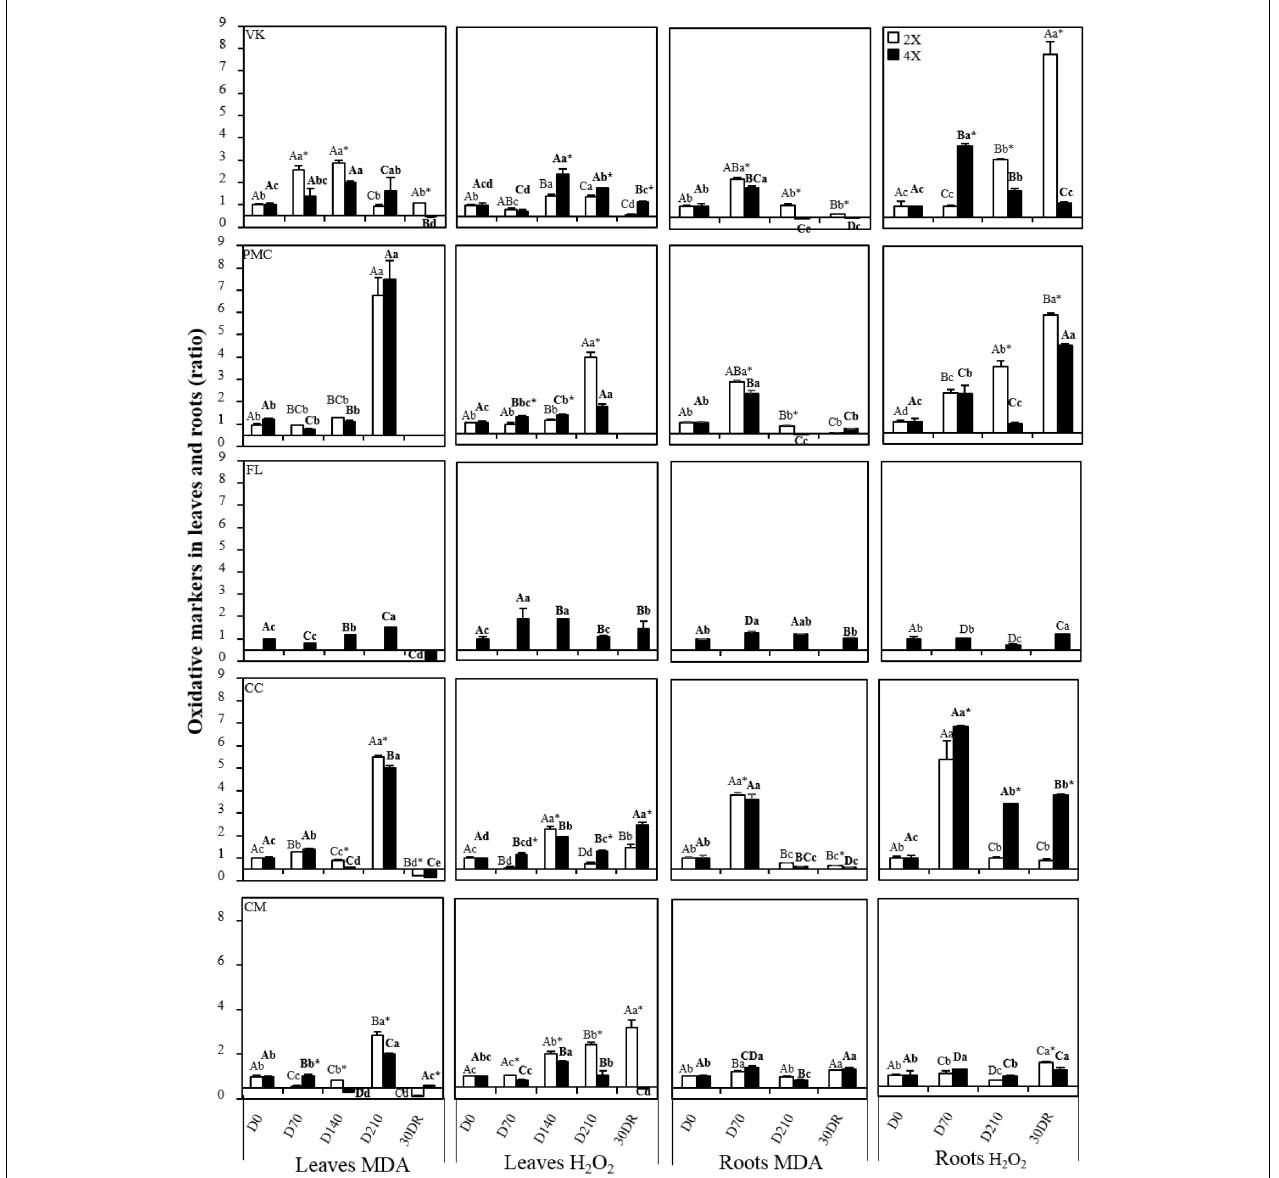
FIGURE 3 | Evolution of malondialdehyde (MDA) and hydrogen peroxide (H 2 O 2 ) concentration, throughout the nutrient deficiency in leaves and roots of 2x and 4x genotypes. The white and black bars correspond to the values obtained from 2x and 4x genotypes, respectively. Concentrations were measured after different period of nutrient deficiency in: days 0 (D0) for the control, 70 (D70), 140 (D140) and 210 (D210) and after 30 days of recovery (30DR) in leaves and days 0 (D0) for the control, 70 (D70) and 210 (D210) and after 30 days of recovery (30DR) in roots. The results obtained are expressed as ratios with respect to the values obtained, respectively, on control leaves and control roots which have not been subjected to stress. The results are presented as mean ( ± standard error) of three independent measurements ( n = 3). Data were analyzed using ANOVA and Fisher LSD tests ( P < 0.05). Distinct capital letter indicate significant differences between all 2x genotypes at a point of the time course. Different lower case letters indicate significant value change along the time course for one 2x genotype. For 4x genotypes, the same procedure has been followed and the results are indicated in bold roman. An asterisk indicates significant differences between 2x and 4x genotypes of the same variety at a point of the time